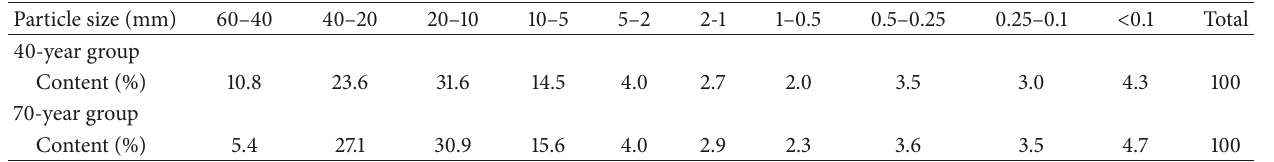
Table 2: Particle size distributions (700